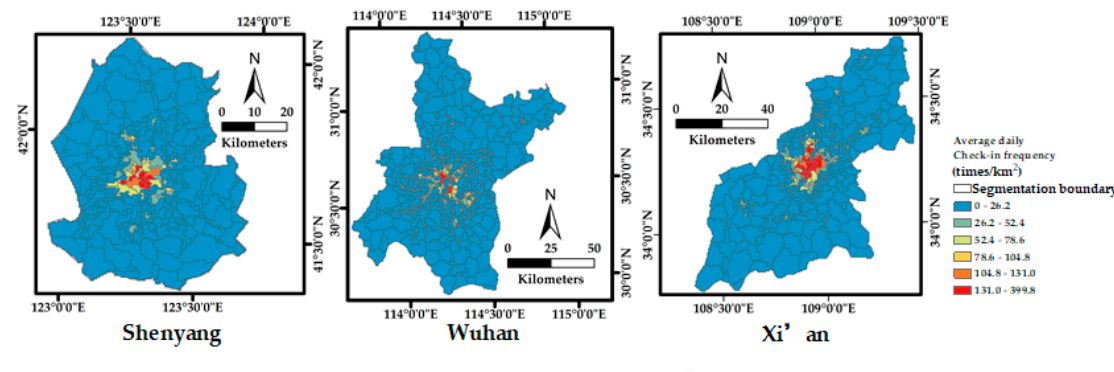
Figure 5. Segmentation results.